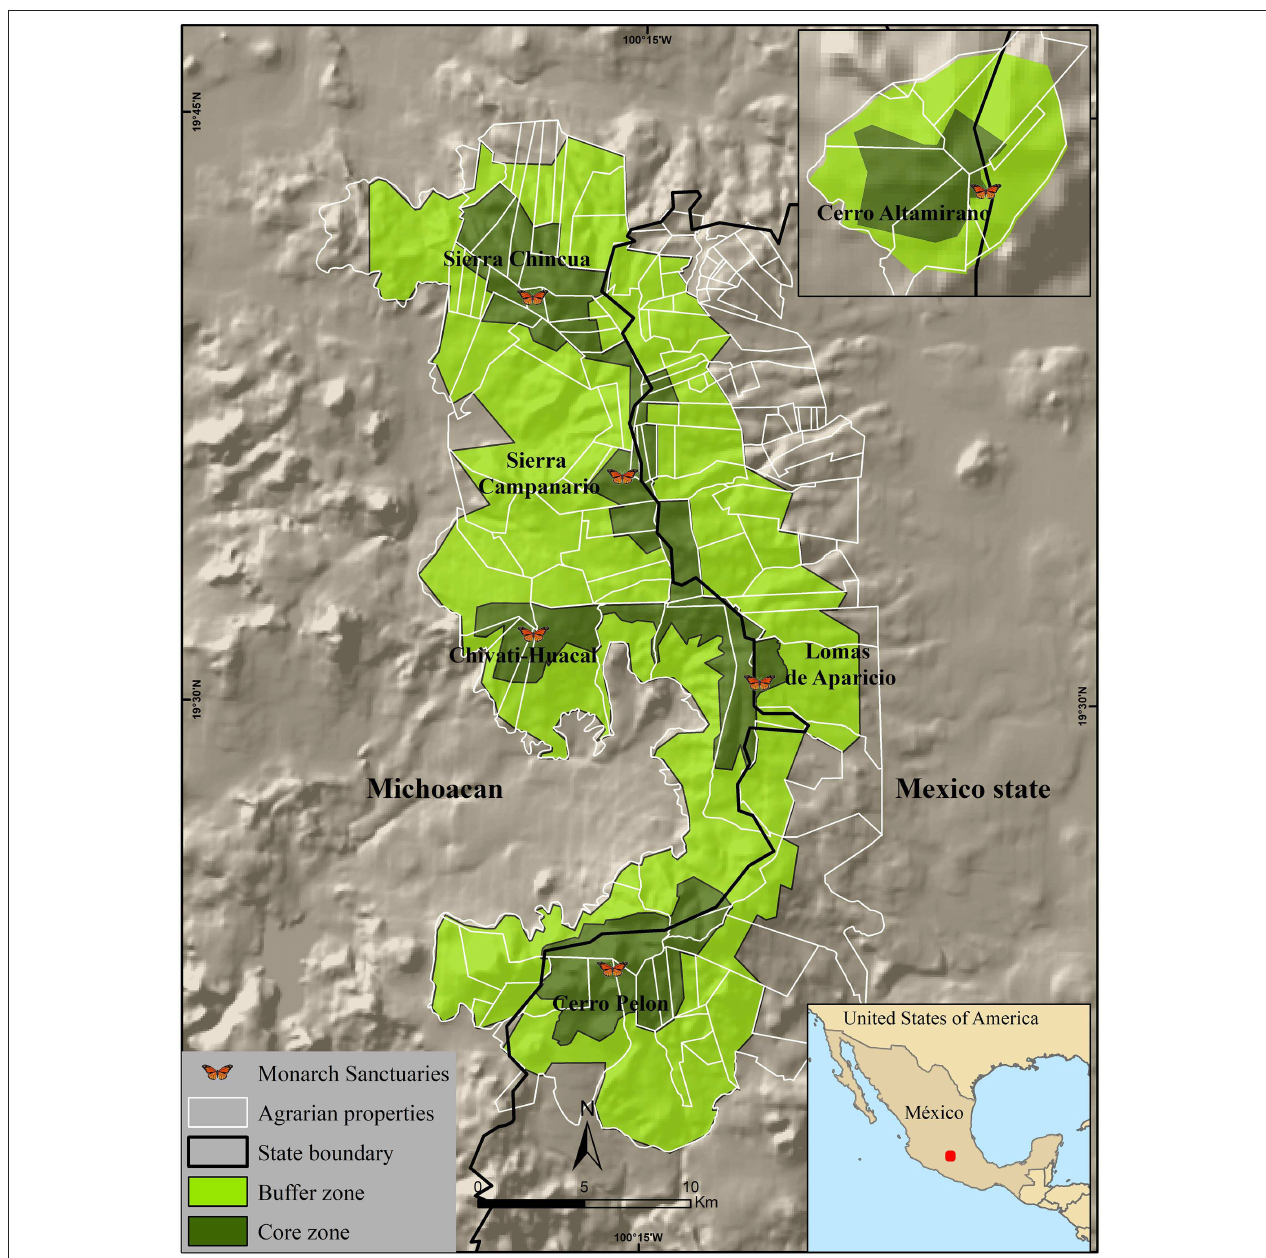
FIGURE 1 | Location of the Monarch Butterfly Biosphere Reserve (MBBR), along the border (thick line) of the States of Michoacan and Mexico. The buffer zones are depicted in light green, and include areas where sustainable use of natural resources is allowed by local communities. The core zones of the MBBR are depicted in dark green, and include areas where use of natural resources is restricted. Monarch overwintering colonies (monarch sanctuaries) are depicted as a red monarch logo. The polygons depicted in the buffer zones represent the agrarian properties owned by the stakeholders [Registro Nacional Agrario, Mexico 2018 (National Agrarian Records, Mexico